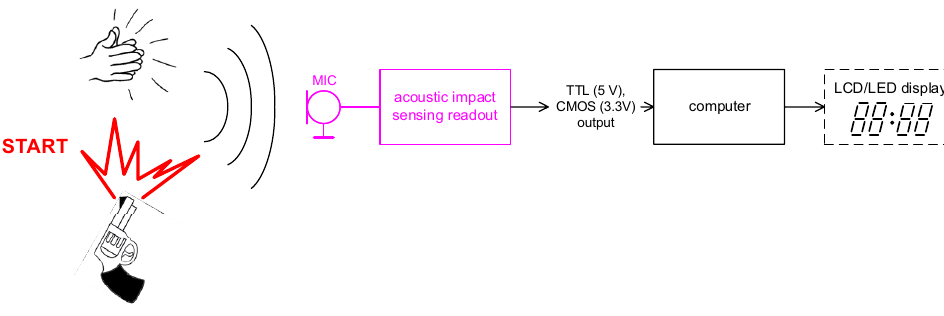
Figure 1. Principle of the sensing readout system for acoustic wave